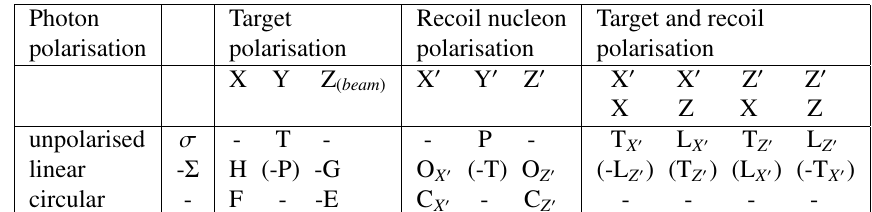
Table 1. Polarisation